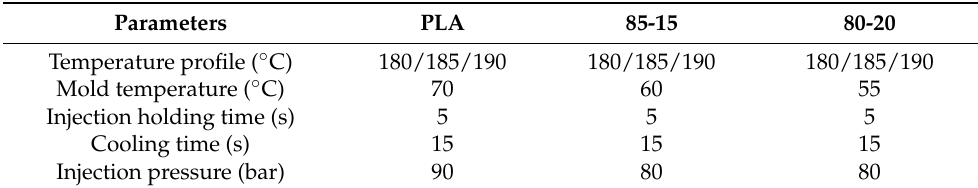
Table 1. Injection molding